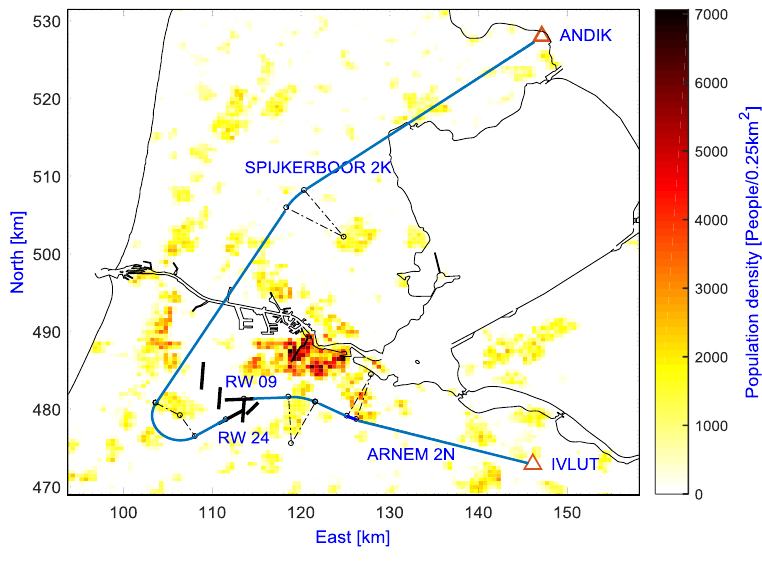
Figure 2. Departure scenarios.